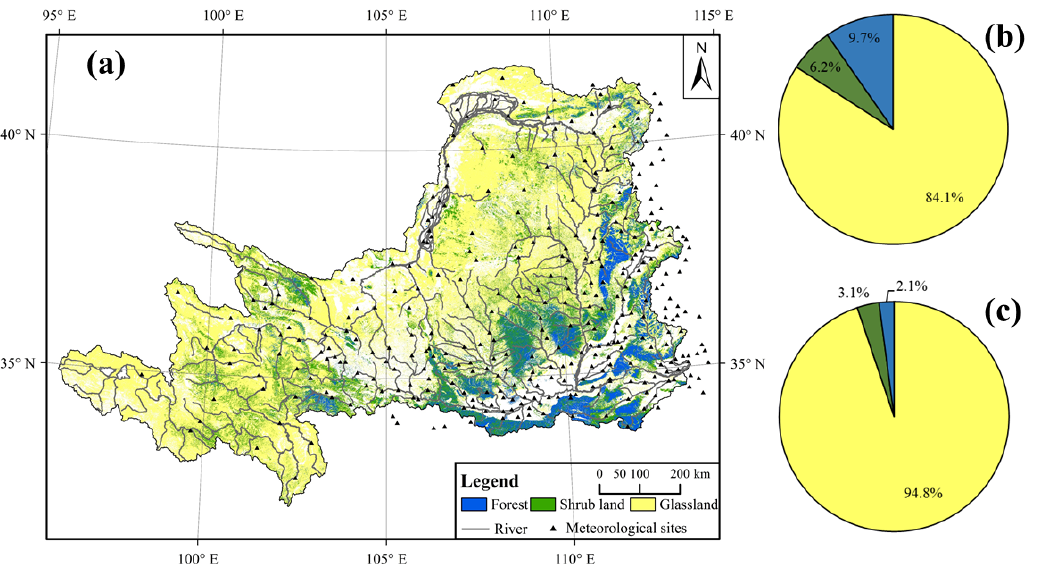
Figure 1. Location and land cover of the Yellow River Basin. ( a ) Location, river, meteorological sites, and land-cover types of the study region in 2015 from CESA land-cover map. ( b ) Area proportion of grassland, forest, and shrub land converted from farmland in the period of 1990 to 2015. ( c ) The area proportion of grassland, forest, and shrub land converted from bare land in the period of 1990 to 2015.